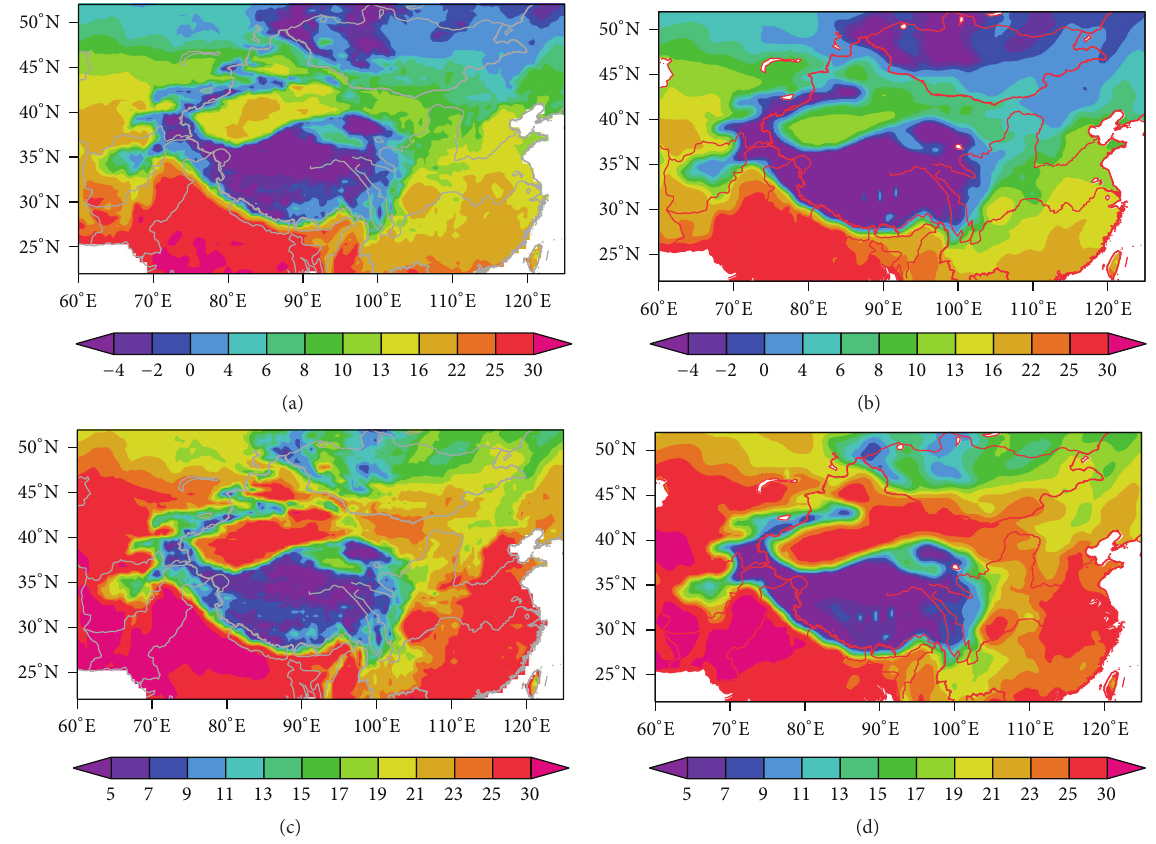
Figure 2: Observed (a, c) and simulated (b, d) surface mean temperature (units: ∘ C) in spring (a, b) and summer (c,